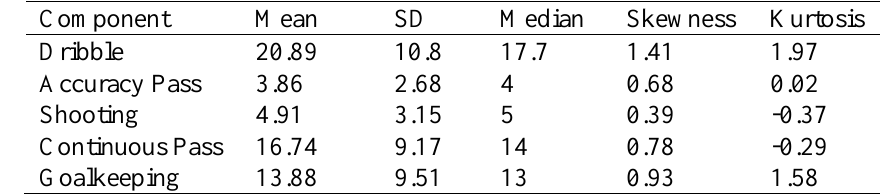
Table 1. BFST-AVI raw score descriptive statistics.